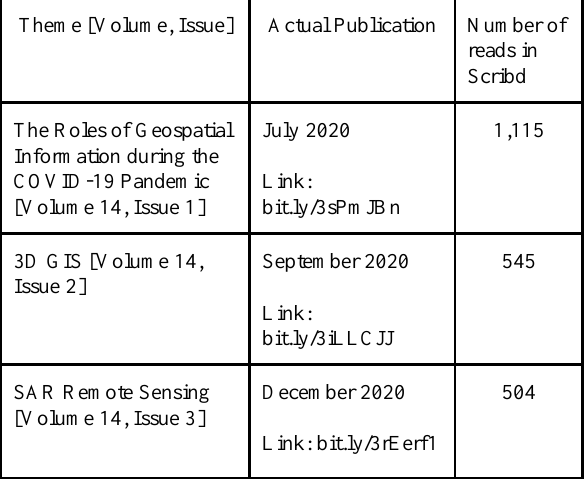
Table 2. The number of reads for the special issues of the ISPRS SC Newsletter, SpeCtrum, taken from Scribd.